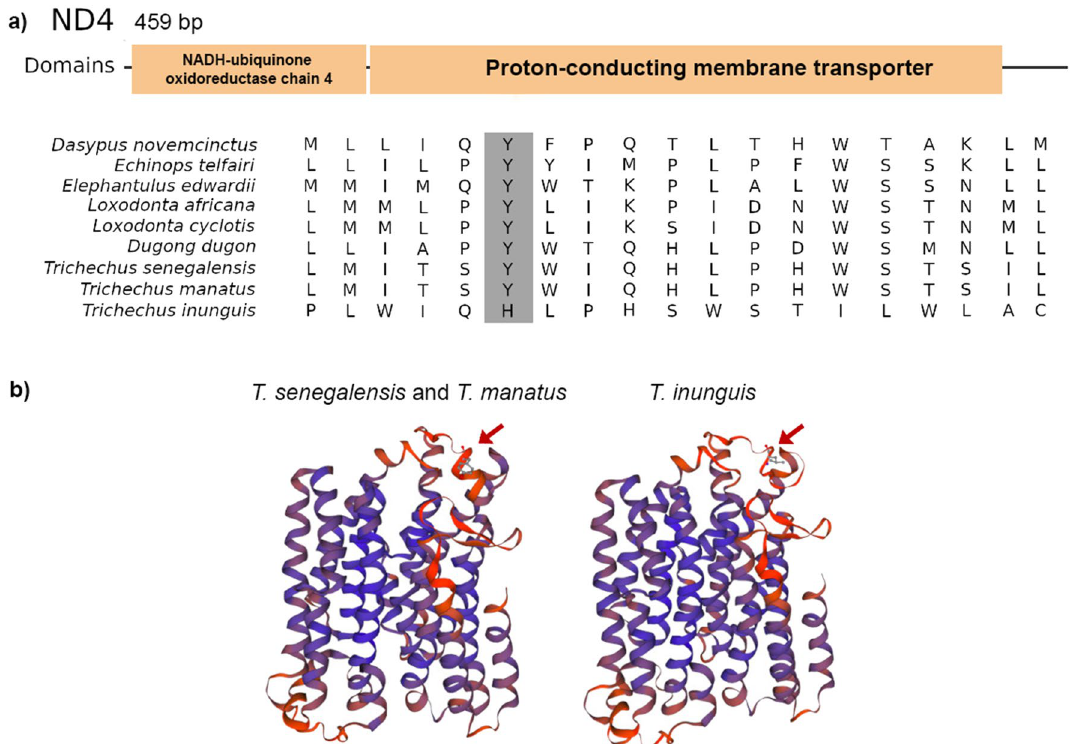
Figure 4. The alignment of ND4 gene, ( a ) represents the ND4 domain and the highlighted indicates the amino acid position of positive selection. ( b ) Modelling protein of ND4 of Trichechu s species; the arrow shows the positive selection